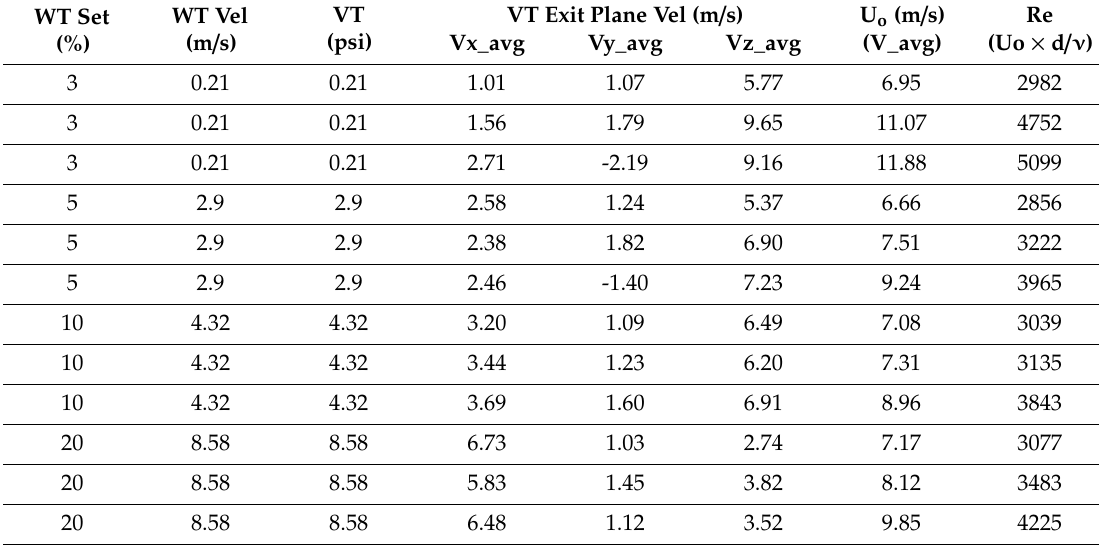
Figure 3. Photography of the pressurized vortex tube and its CAD model inside the wind tunnel and in a typical configuration upstream of an airfoil. Geometry and dimensions (inches) shown.